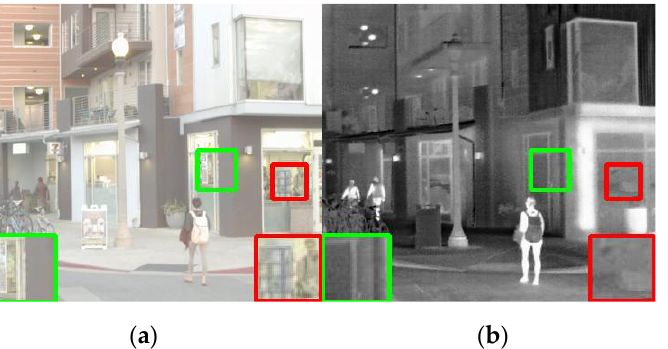
Figure 8. The fusion strategy compares the source image of the experiment, ( a ) Visible image, ( b ) Infrared image. ( b ) Infrared